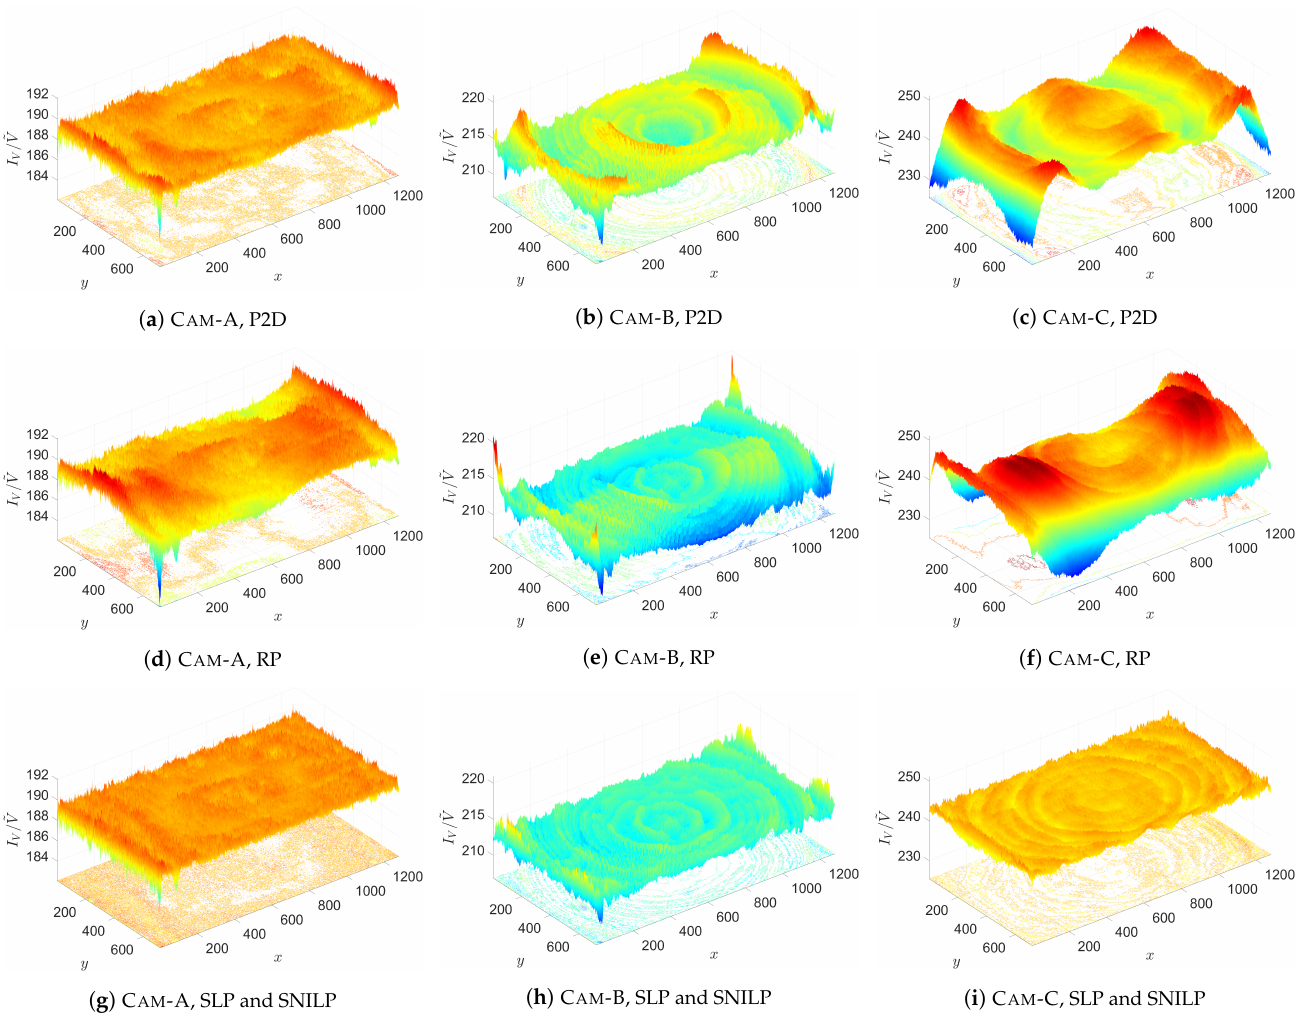
Figure 9. Comparison of vignetting correction of flat-field image I V for the tested cameras and vignetting models for degree s = 10 of the used approximation polynomials. The charts ( j – i ) present results obtained for the SLP and SNILP models, which, in the case of the used parameter k = 25 (number of iterations), in the SPL model, are